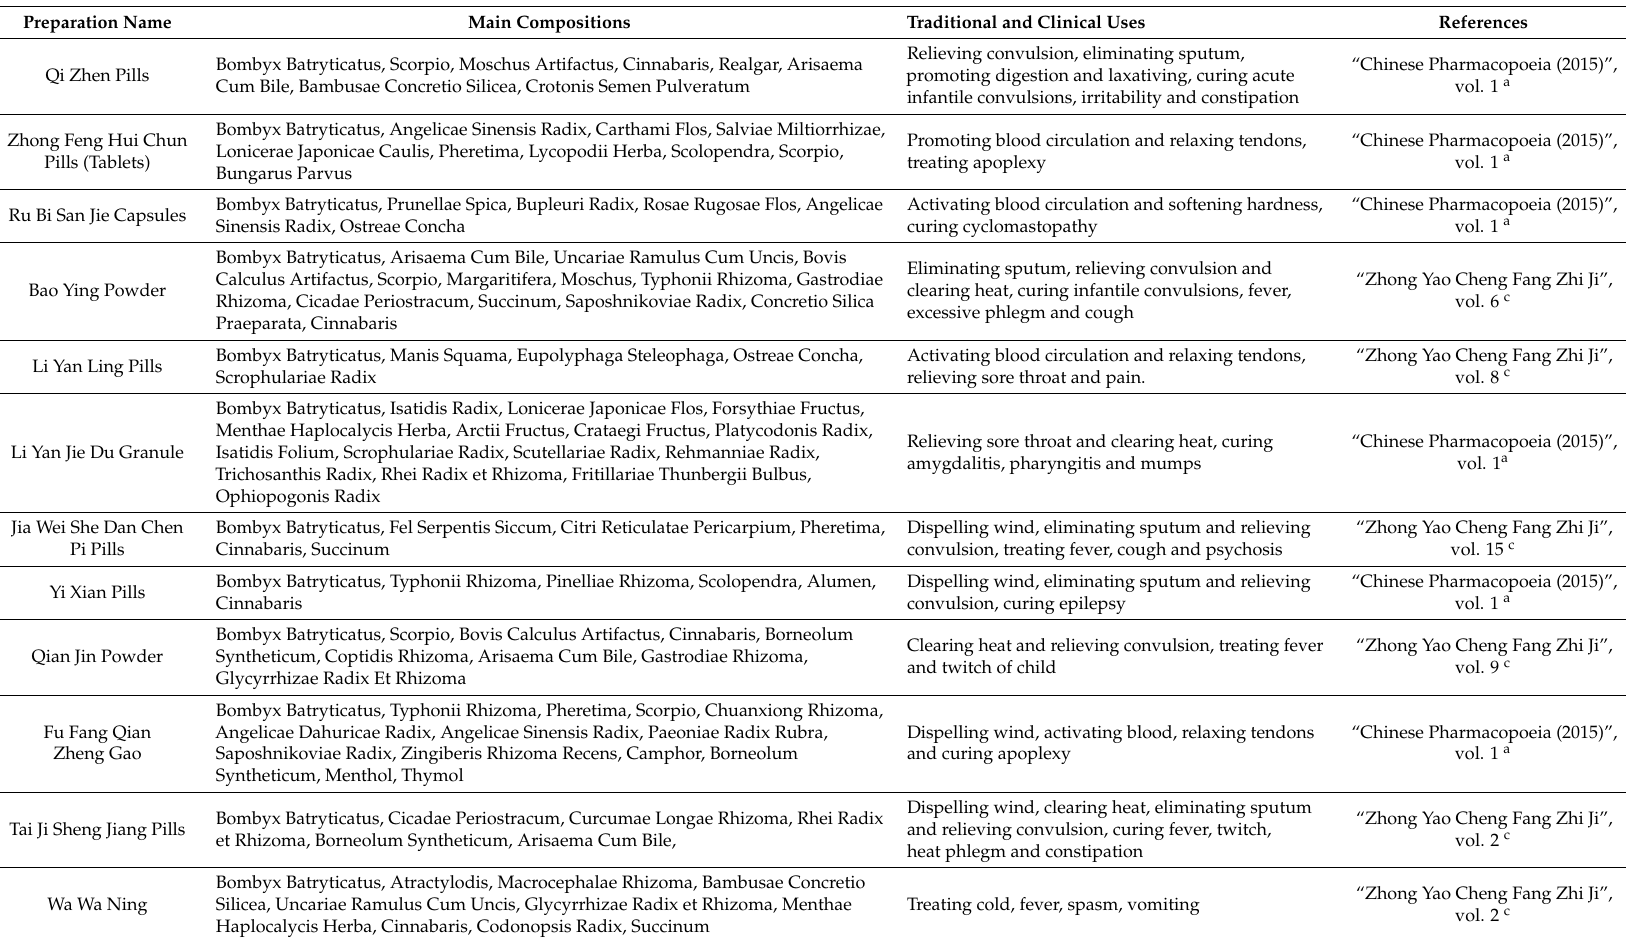
Table 1. The traditional and clinical uses of B. batryticatus in